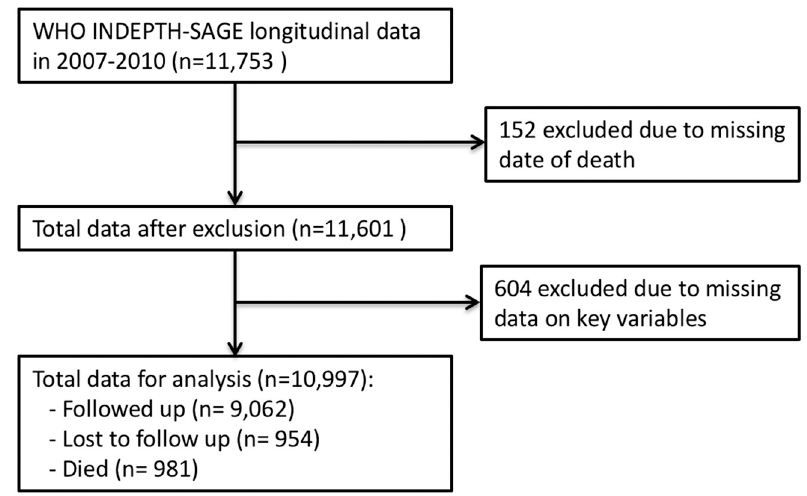
Figure 1. Flowchart of the study population generated from WHO-INDEPTH SAGE Purworejo longitudinal data.